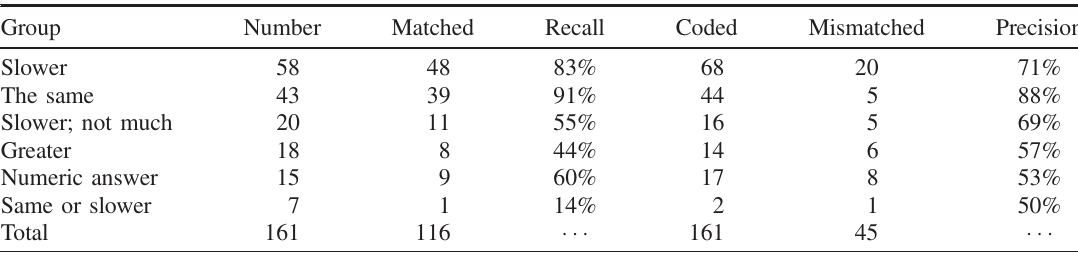
TABLE III. Group-by-group matching for the ball and track activity.